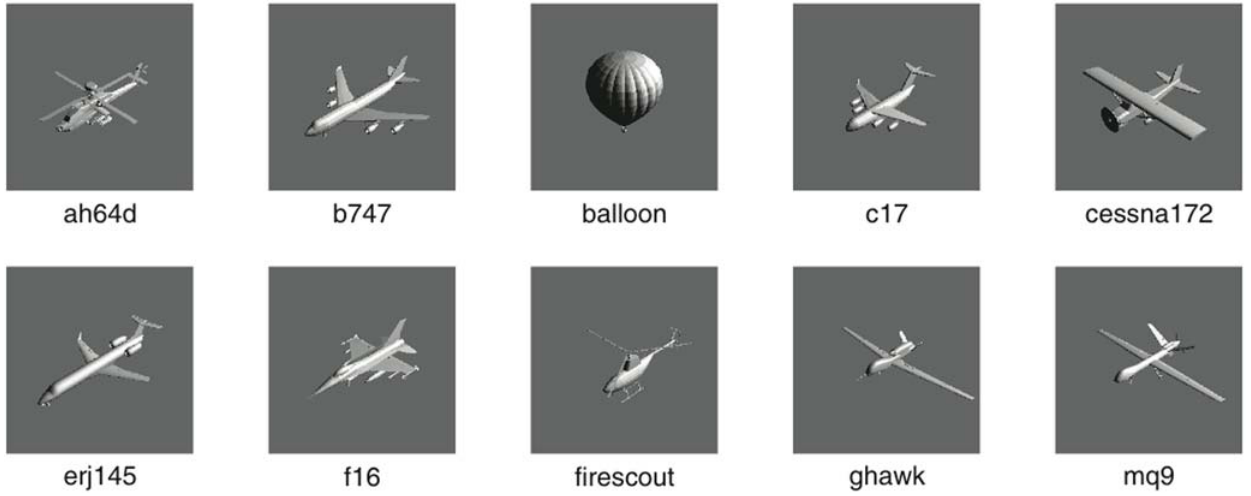
Figure 4. The ten aircraft used in the experiment. A 2D rendered image and short name for each model is shown. doi:10.1371/journal.pone.0005594.g004 Table 1. Aircraft models and aircraft dimensions in